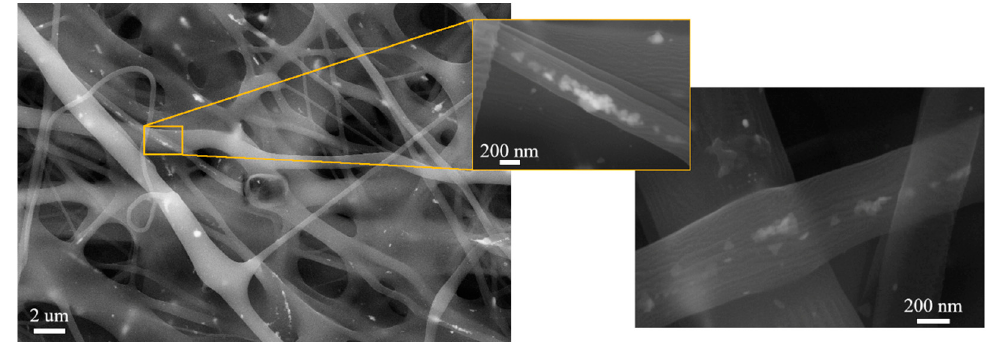
Figure 8. SEM microphotograph of AgNPs clusters in PVA–AgNPs nanofibers of non-woven textiles, sample B, and the detail of the nanoparticles in the fibers.